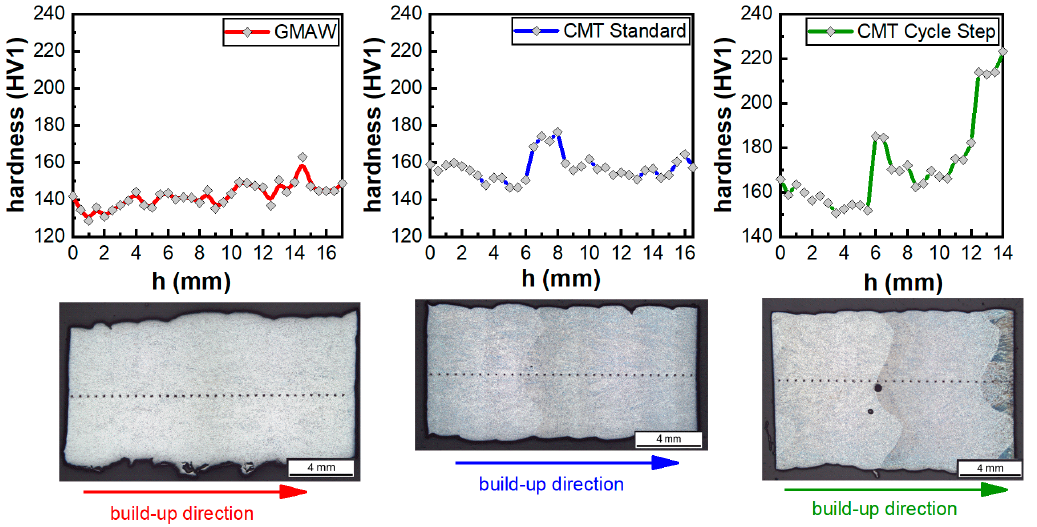
Figure 8. Hardness distribution in the build-up direction.